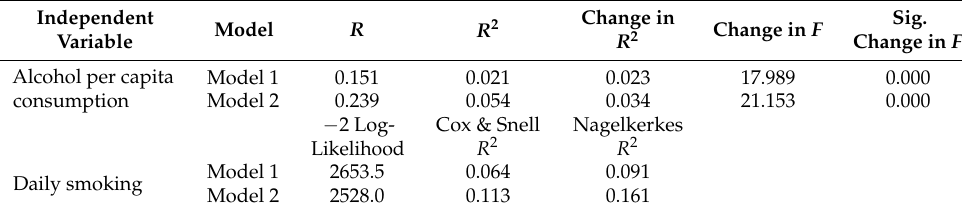
Table 3. Model summaries.